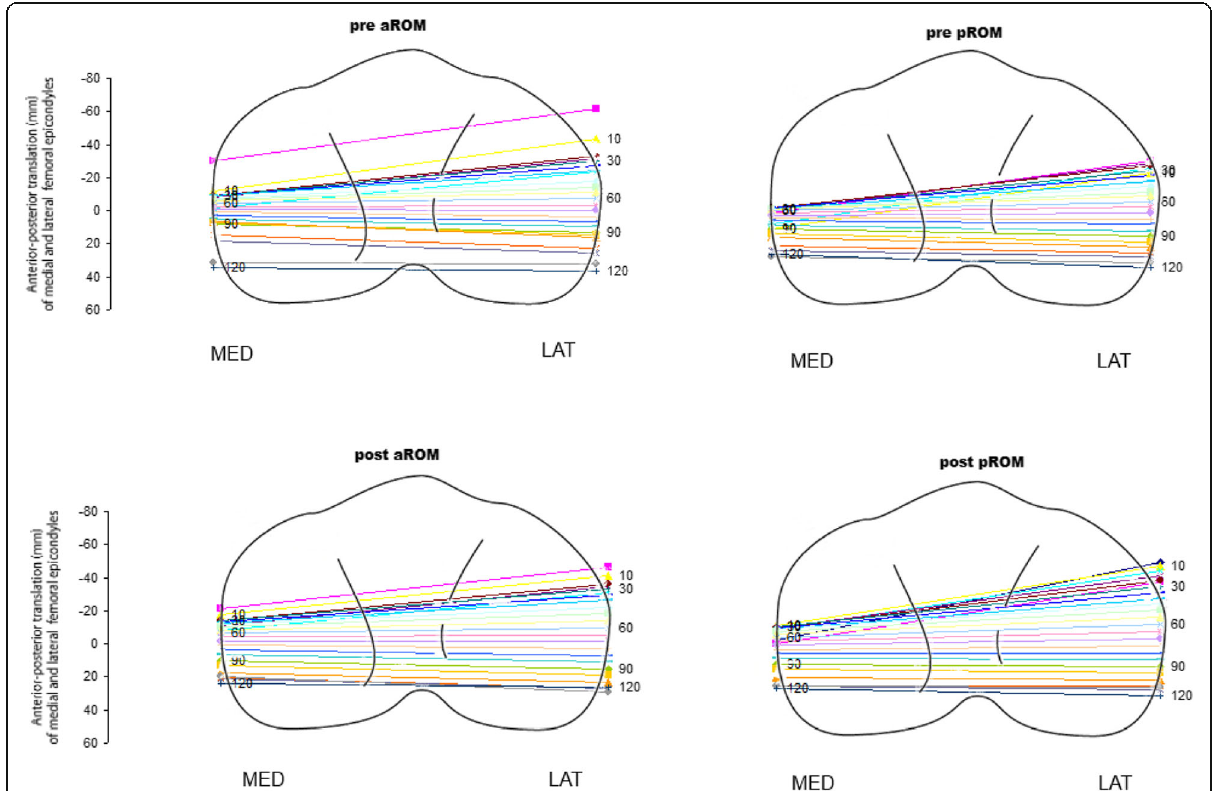
Fig. 5 Pre-operative (top) and post-operative (bottom) active and passive antero-posterior translation of the femur with respect to the